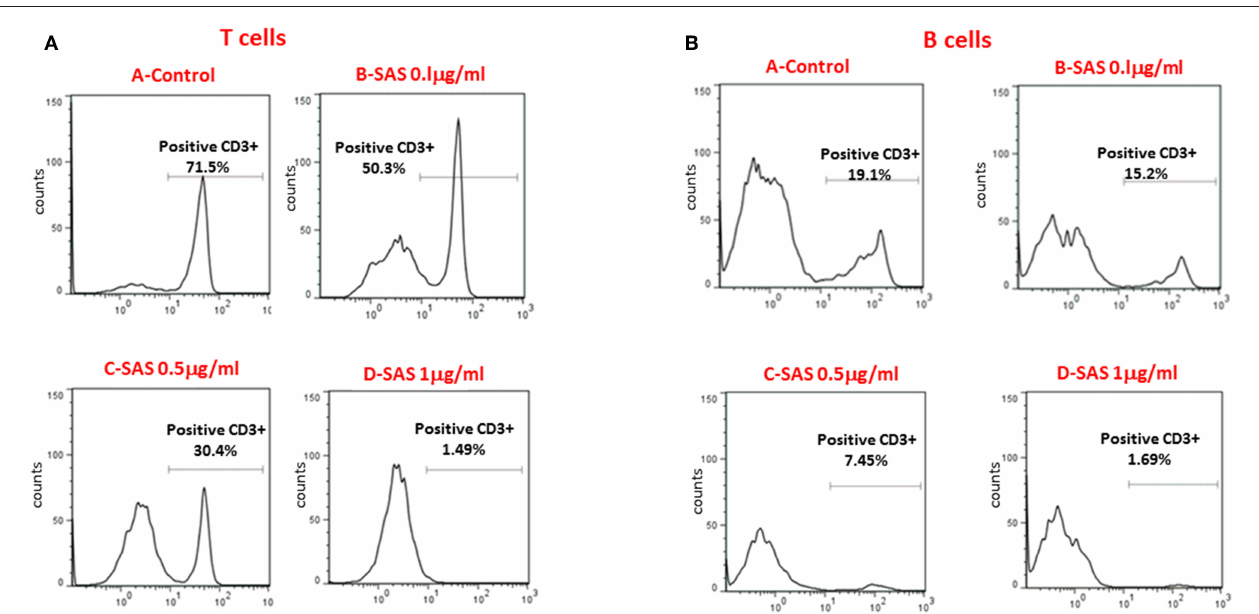
FIGURE 4 | SAS inhibits in vitro attachment of T and B lymphocytes from NOD mice to the high endothelial venular (’HEV’) cells (SVEC-4) . Cells were washed twice. Eighty percent confluent endothelial SVEC cells in 6 well plates were stimulated with TNF α to induce MAdCAM-1 expression. After 10h, 3 × 10 6 splenocytes from 10 week old NOD mice were added in the presence or absence of various concentrations of SAS o.n.. Culture plates were washed and the attached cells were removed and stained with FITC-conjugated anti CD3, and APC-conjugated anti B220 antibodies for the detection of attached T (A) or B (B) cells. The results represent one experiment, representative of three